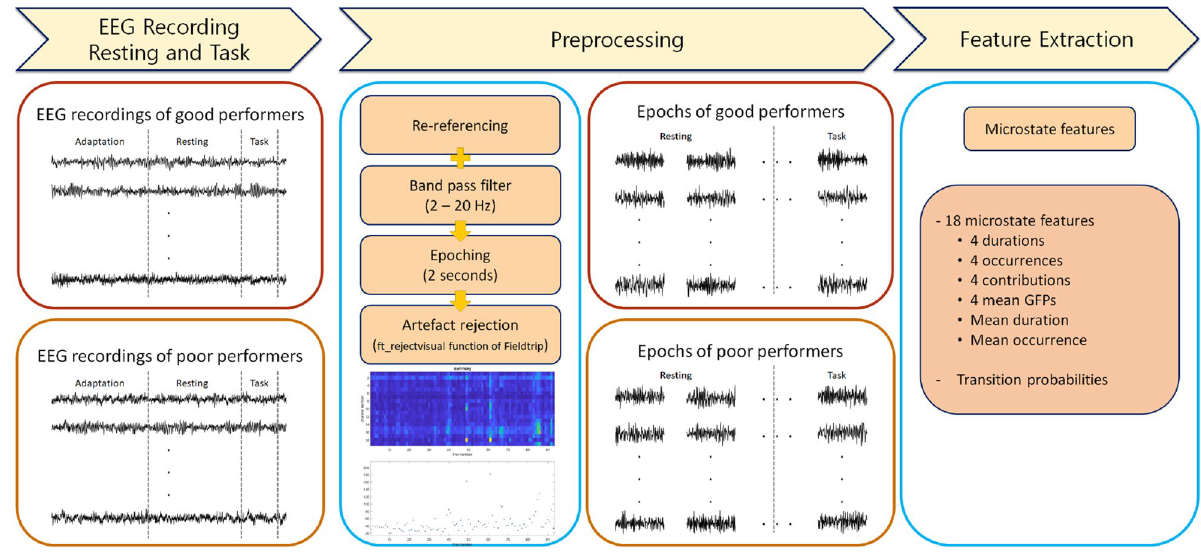
Figure 7. Overview of the process for extracting EEG microstate features. EEG electroencephalography, GFP global field potential, PR poor performers in resting state, PT poor performers in task state, GR good performers in resting state, GT good performers in task